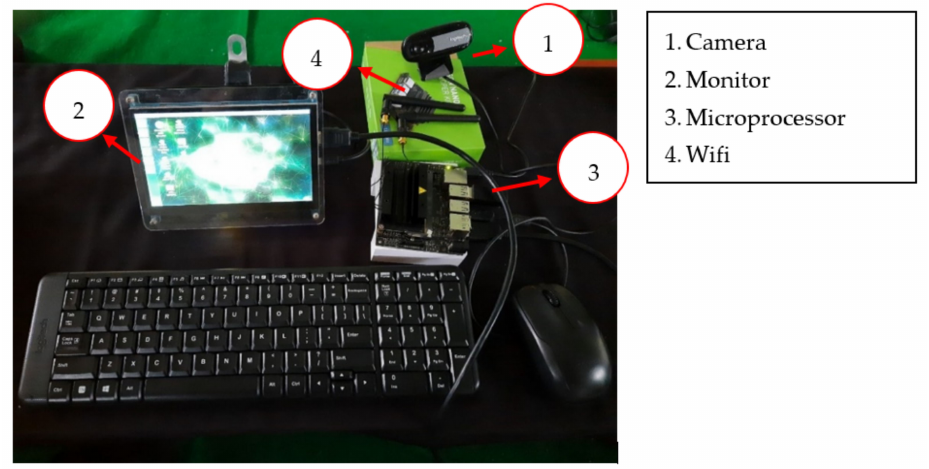
Figure 15. Equipment used for ECG image detection in hardware